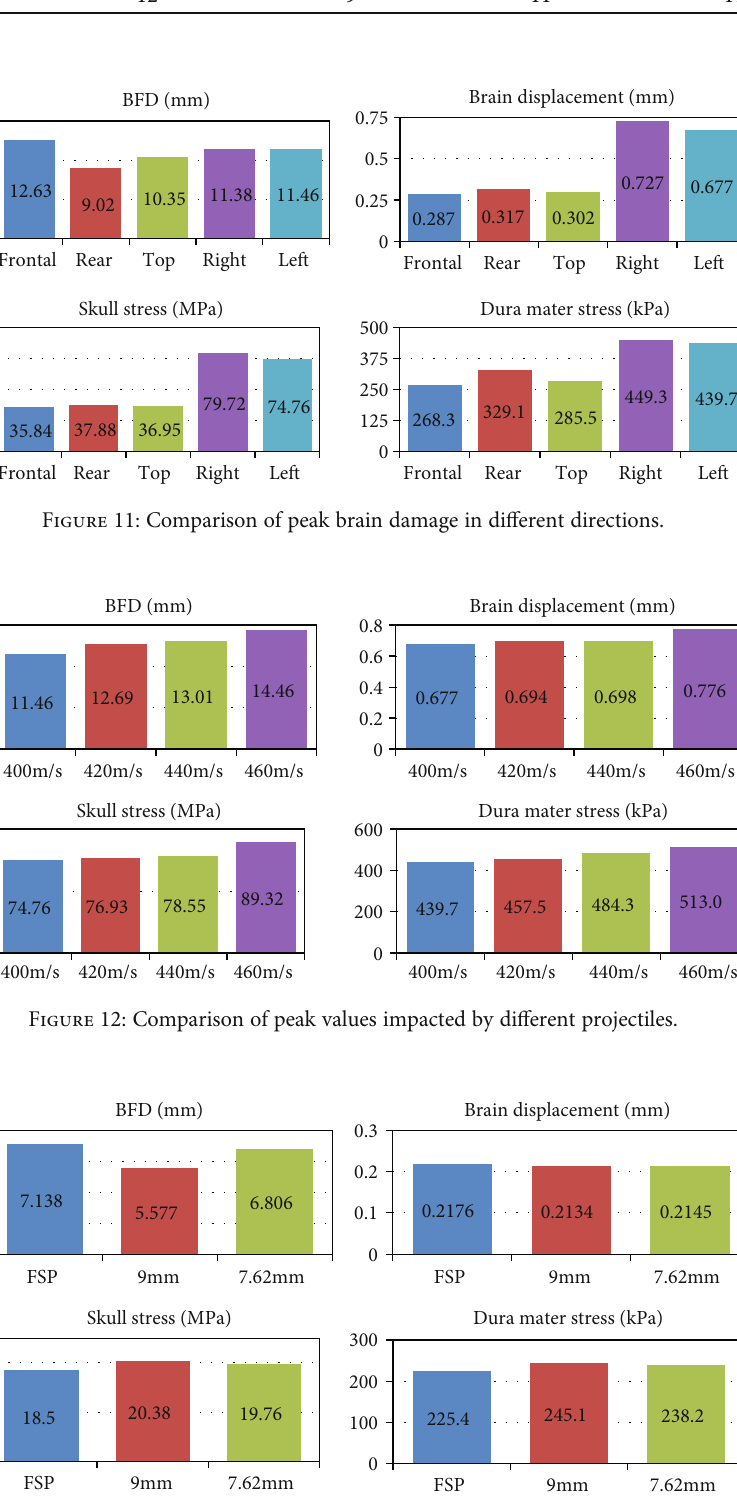
Figure 13: Comparison of peak values impacted by di ff erent projectile